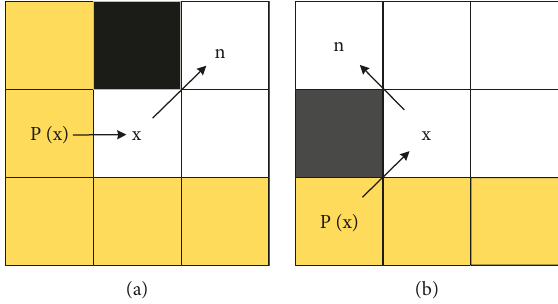
Figure 4: Forced neighbor node. (a) Straight line direction. (b) Diagonal